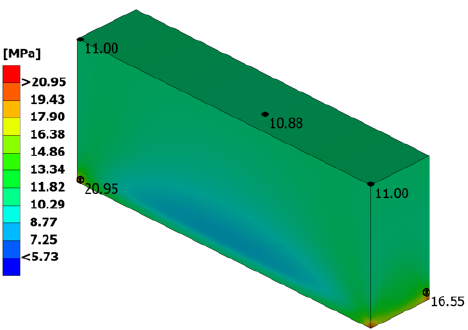
Figure 4. Finite element mesh view of polymer specimen with spraying.